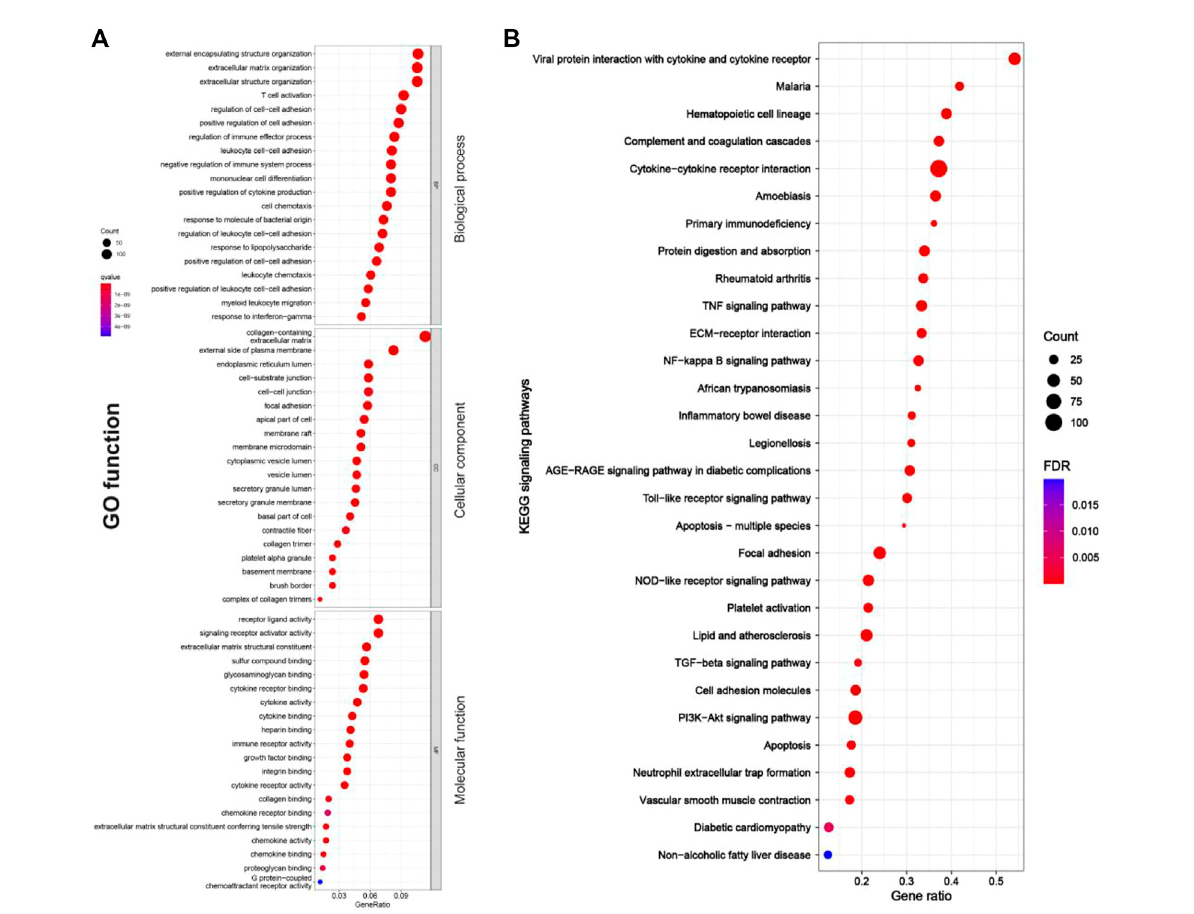
FIGURE 5 GO function and KEGG pathway enrichment results of RF-related DEGs in adenine model. (A) Bubble charts of GO enrichment analysis, the Y axis displayed biological process, cellular component, and molecular function modules, the X axis represented gene ratio, count (the size of the nodes) indicated gene number, and qvalue (the intensity of the color) referred to -log10 p -value. (B) Bubble charts of 30 KEGG signi fi cant pathways with p < 0.05, the Y -axis displayed pathways, the X -axis represented gene ratio, count (the size of the nodes) indicated gene number, and FDR value (the intensity of the color) referred to -log10 p